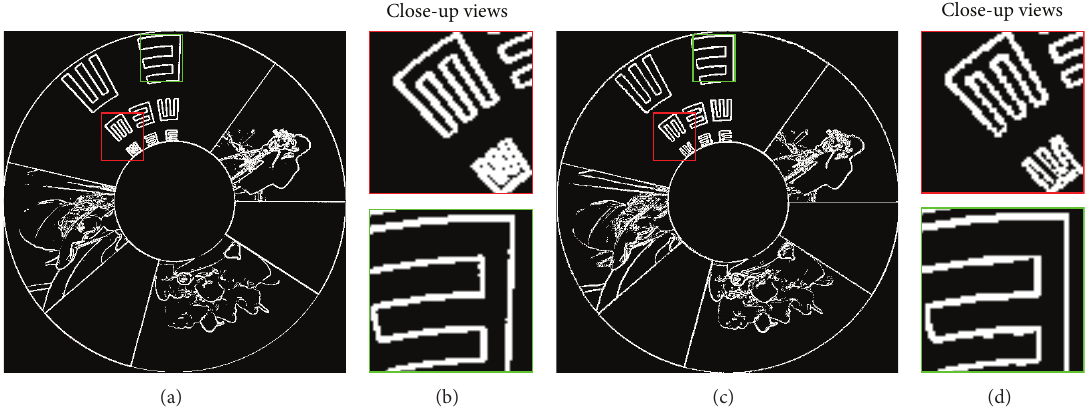
Figure 6: Gradient computation results of test image: (a) and (b) are traditional gradient computation result and close-up views, respectively; (c) and (d) are omnigradient computation result and close-up views, respectively.